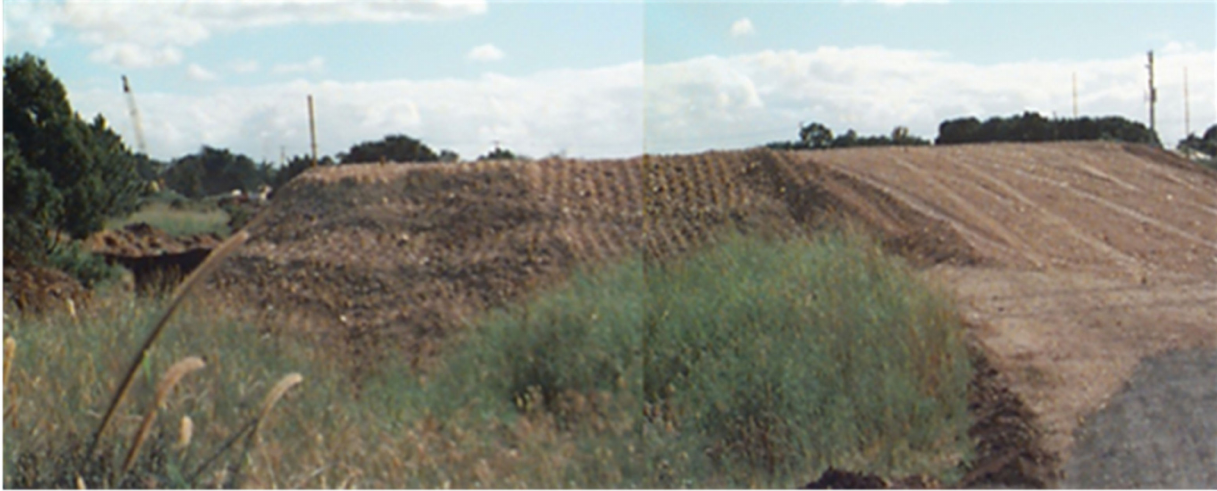
Figure 1. The Nerang Broadbeach Roadway embankment near Chainage